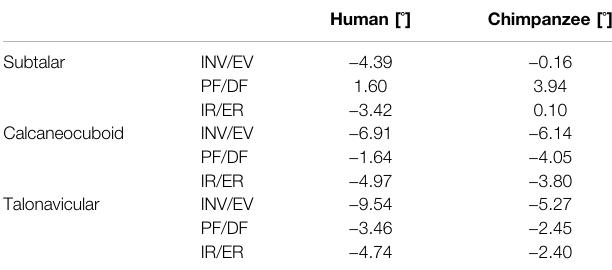
TABLE 3 | Angular displacements of foot tarsal joint (subtalar, calcaneocuboid, navicular joint) during quiet standing of human and chimpanzee; positive values indicate inversion, plantar fl exion, and internal